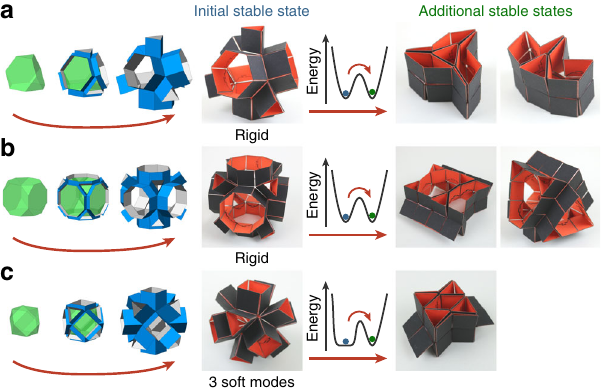
Fig. 1 Prismatic structures and some of their stable states. The prismatic structures can be designed by extruding the edges of a convex polyhedron perpendicular to the faces. The multistable examples shown here are based on a a truncated tetrahedron, b a truncated cube and c a cuboctahedron. The additional stable states can only be reached by going over a fi nite energy barrier resulting from deformation of the faces of the structure. The prototypes have square faces of 24 mm made from cardboard (0.4 mm thick) and connected through hinges made from double-sided tape 6